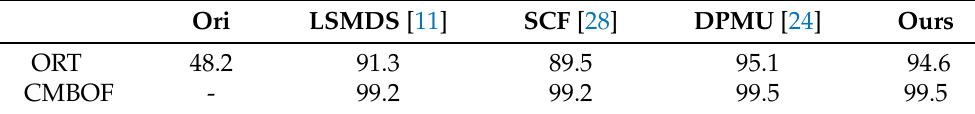
Table 3. Retrieval accuracy for different methods on the dataset